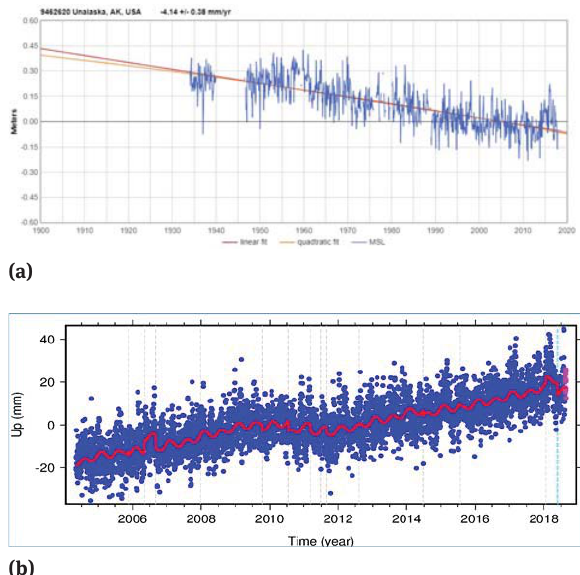
Figure 6: (a) MSL data for Unalaska, AK, USA. Image reproduced modified after [4]. (b) GNSS time series for AV09. Image reproduced modified after NGL.